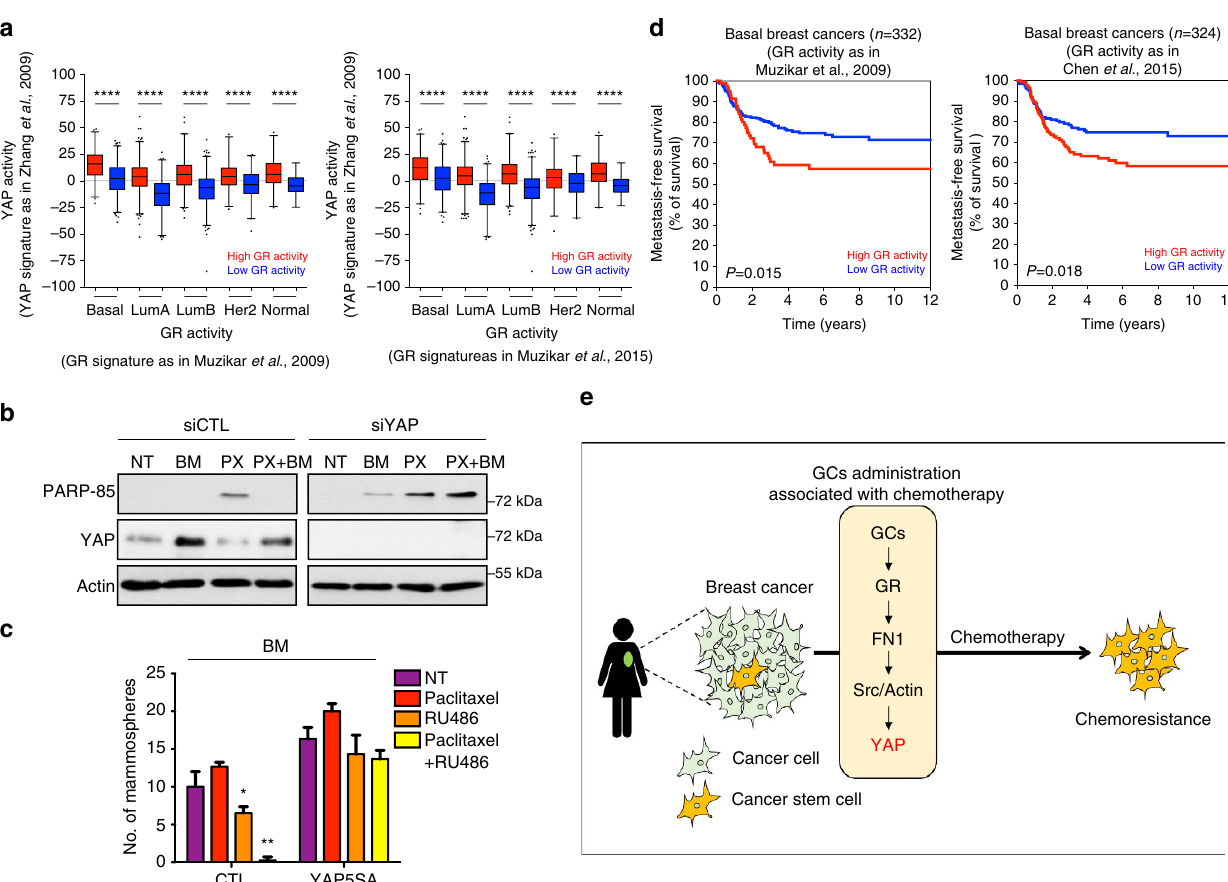
Figure 7 | Glucocorticoid receptor activation correlates with YAP activity in breast cancer and is involved in chemoresistance. ( a ) Primary human breast cancers of the metadata set were stratified according to high or low GR activity signature (left panel 40 ; right panel 25 ) and then, the levels of the YAP activity signature score were determined in the intrinsic molecular subtypes (PAM50). YAP activity is significantly higher in breast cancers with higher levels of the GR activity signature, as visualized by the box plot. Signature scores have been obtained, summarizing the standardized expression levels of signature genes into a combined score with zero mean 70 . The values shown in graphs are thus adimensional. The bottom and top of the box are the first and third quartiles, and the band inside the box is the median; whiskers represent 1st and 99th percentiles; values that are lower and greater are shown as circles (**** P o 0.0001, two-tailed Student’s t -test). ( b ) MDA-MB-231 cells transfected with control (siCTL) or YAP (siYAP) siRNA and treated with vehicle (NT) or betamethasone 1 m M (BM) and paclitaxel 0,1 m M (PX) alone or in combination for 48h. Representative blots are shown. Experiment repeated three times. siYAP sequence is siYAP#1. ( c ) Number of secondary mammospheres generated from MII cells overexpressing control vector (CTL) or YAP5SA and treated as in a, with indicated compounds. Error bars represent mean ± s.d., from n ¼ 3 biological replicates. ( d ) Kaplan–Meier analysis representing the probability of disease-specific survival in basal breast cancer from the metadata set stratified according to high or low GR signature score (left panel 40 ; right panel 25 ). The log-rank test P value reflects the significance of the association between high levels of the GR signature score and shorter survival in GR signature high as compared with GR signature low patients ( P o 0.05). ( e ) Proposed working model. * P o 0.05, ** P o 0.01; two-tailed Student’s t -test is used